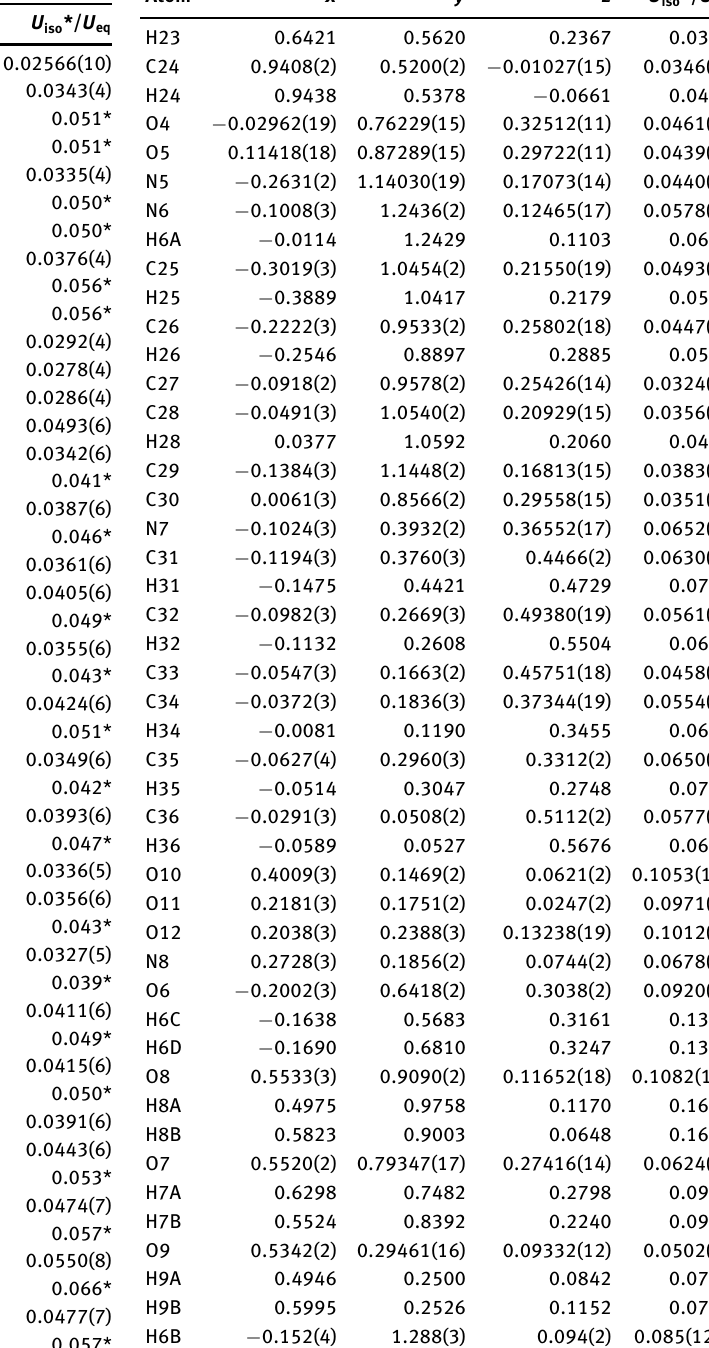
Table 2: Fractional atomic coordinates and isotropic or equivalent isotropic displacement parameters (Å 2 ).